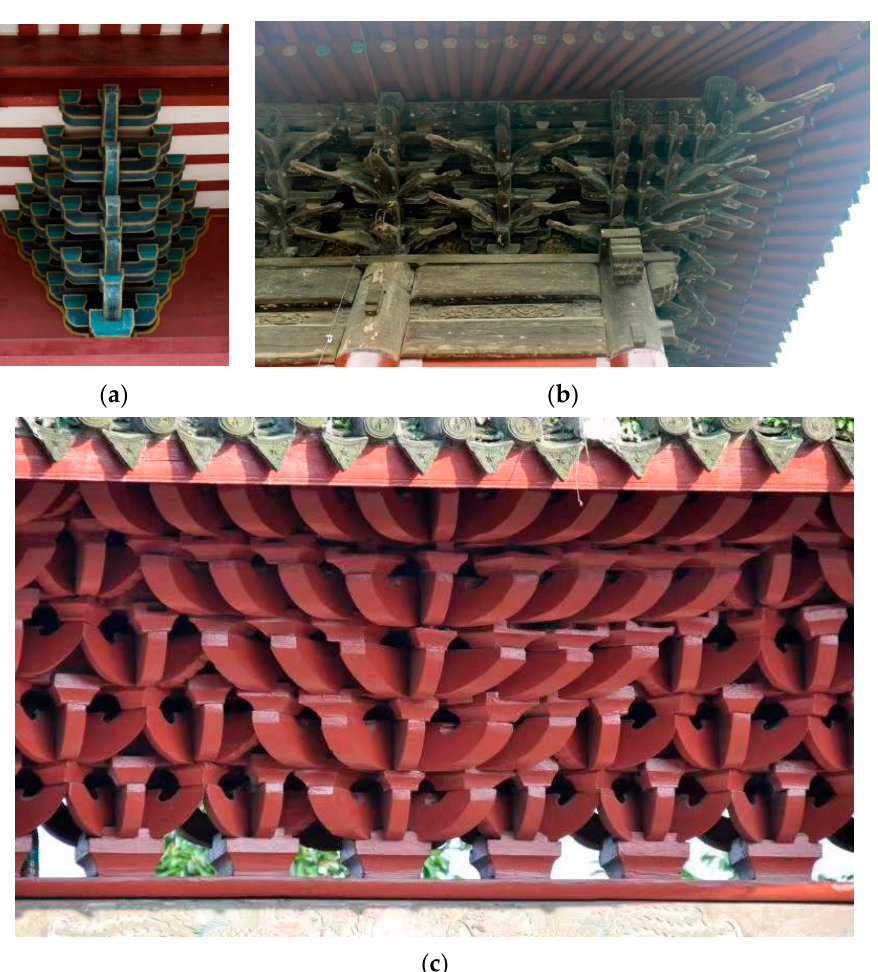
Figure 1. Comparison between the official Dougong and the Xiegong: ( a ) Offical Dougong; ( b ) Xiegong from Pingwu Baoen Temple Wanfo Pavilion; ( c ) Xiegong from Yibin Zhenwu Mountain Archway.